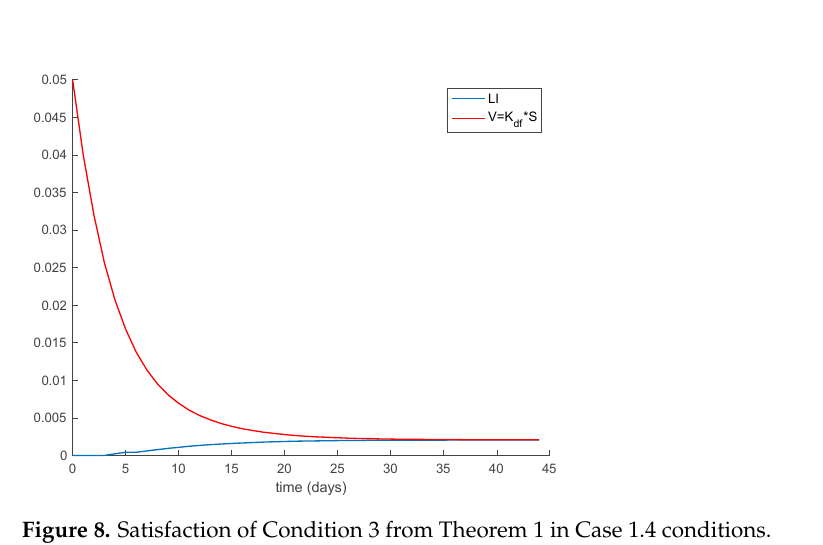
Figure 7. Sequences of populations for Case 1.4 conditions. The vaccination gain employed in this simulation with constant loss of immunity with delay.